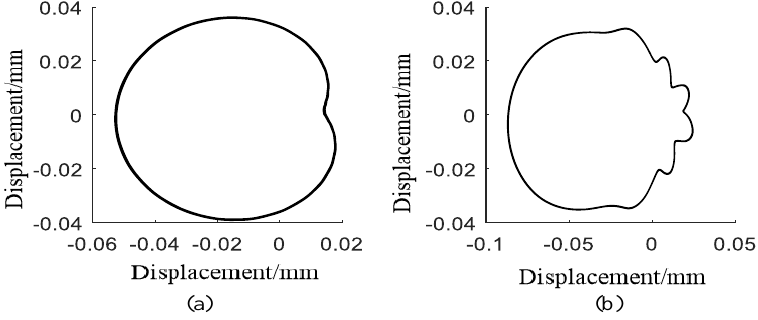
Figure 8. Time domain waveform of generator rotor vibration: ( a ) misalignment 3 mm, short-circuit 1%; ( b ) misalignment 3 mm, short-circuit 10%.